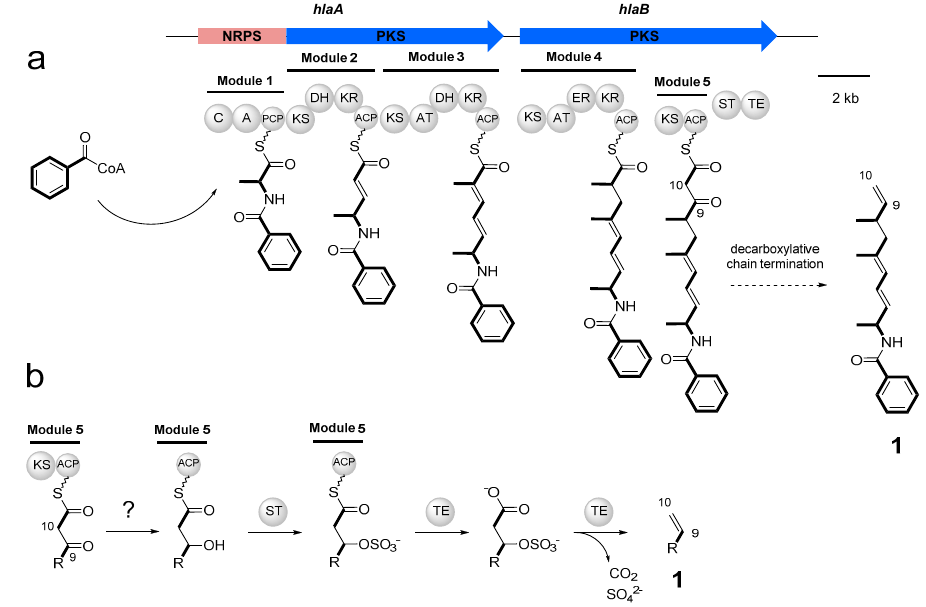
Figure 4. Proposed biosynthetic machinery of haliamide ( 1 ). ( a ) Genetic organization of the haliamide biosynthetic gene cluster ( hla , 21.7 kbp) and a biosynthetic pathway for 1 ; ( b ) Decarboxylative chain termination at the final step leading to the formation of the terminal olefin at C-9 and